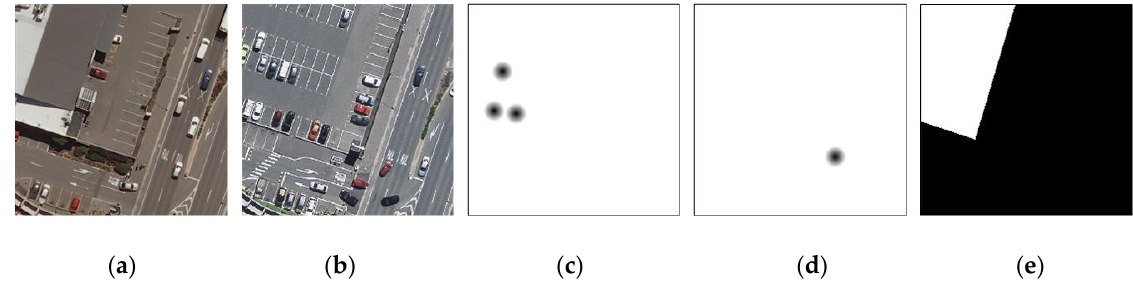
Figure 8. Training sample. ( a ) Image1; ( b ) Image2; ( c ) Positive Clicks; ( d ) Negative Clicks; ( e ) La- bel.